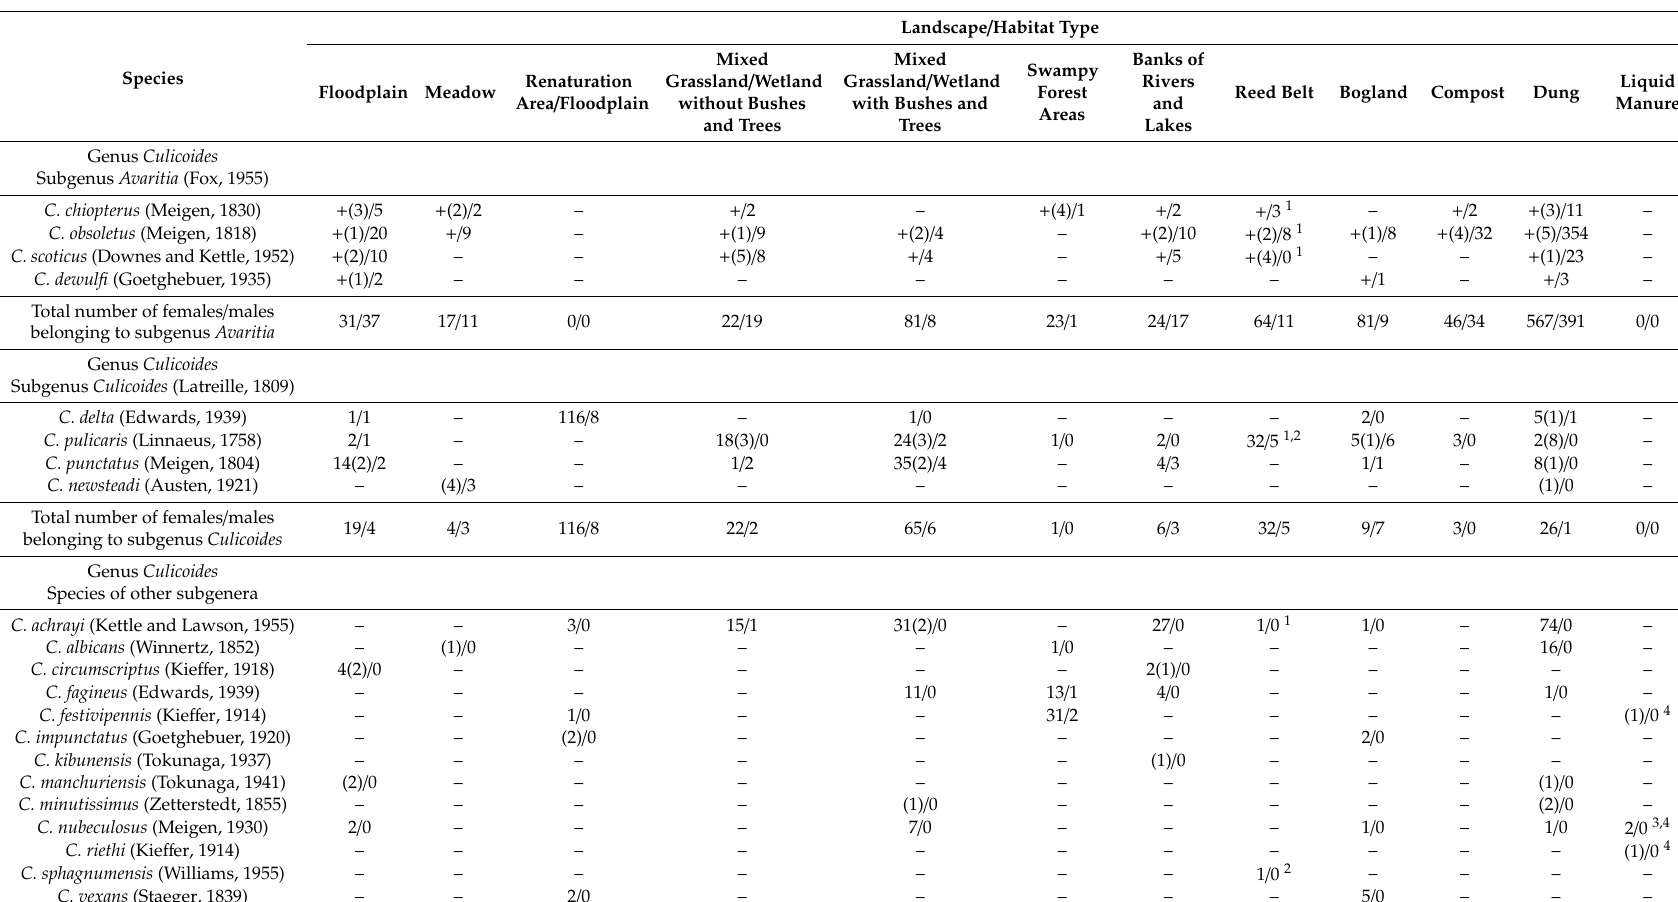
Table 1. Emergence of biting midge subgenera and species according to landscape / habitat type (adjusted to a covered ground area of 0.5 x 0.5 m 2 ), based on both qualitative and quantitative data from the years 1994, 2005 and 2007–2012 (females / males; + —present, − —no record; 1 —on lakes; 2 —on rivers; 3 —on liquid cattle manure; 4 —on liquid sheep manure; numbers in parentheses represent the number of genetically identified females).